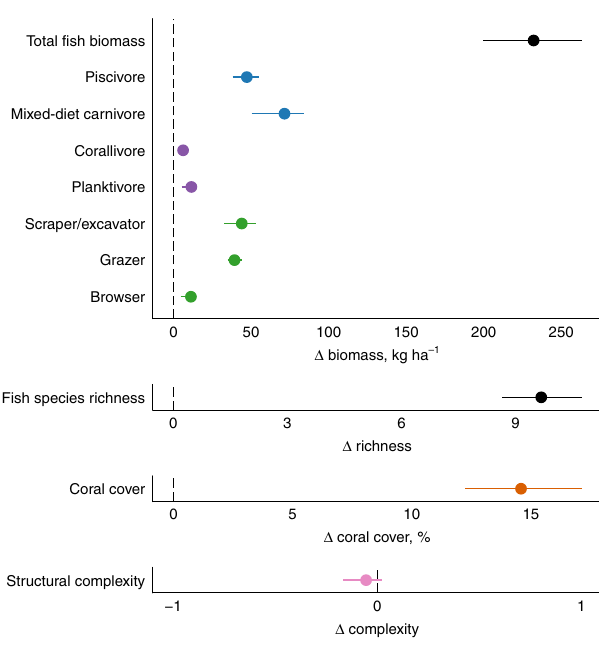
Fig. 1 Marine reserve effects before mass coral bleaching. Points are the average change in each ecological variable on nine reef reserves relative to 12 fi shed reefs (0 = equal values on reserve and fi shed reefs). Error bars are drop-one jackknife con fi dence intervals showing the variance in reserve effects attributable to individual reef sites. Triangles denote ‘ change in ’ . Pre- bleaching macroalgal cover was negligible at all 21 sites and is excluded here (mean = 1.2% ± 5.66 standard error). Corresponding log response ratio values provided in Supplementary Fig. 2. Source data are provided as a Source Data fi